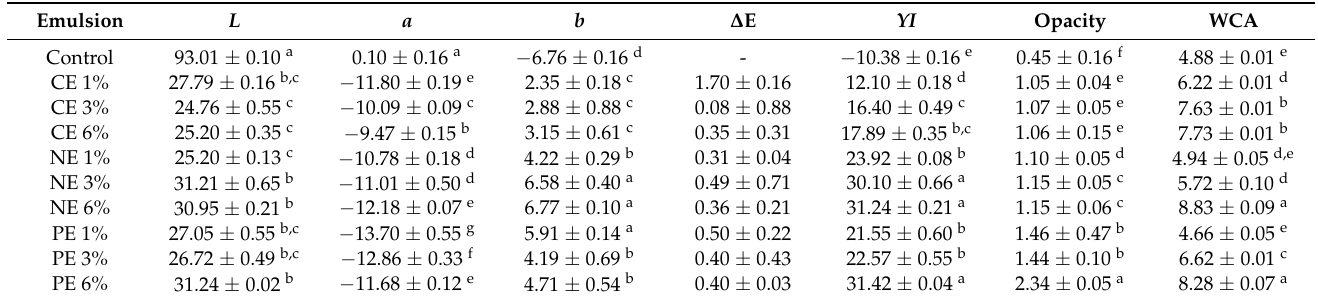
Table 2. Optical characteristics of LDPE film-treated cold plasma-stabilized